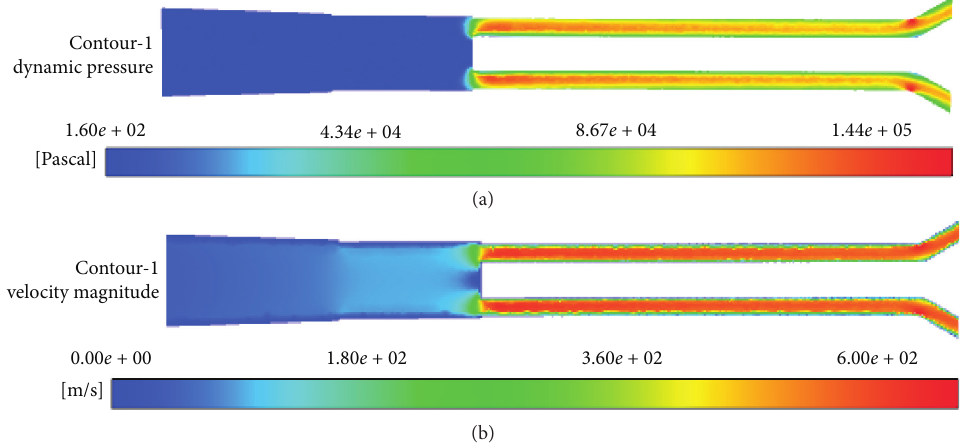
Figure 2: Distribution of front flow field of the throttle. (a) Dynamic pressure distribution. (b) Velocity distribution.